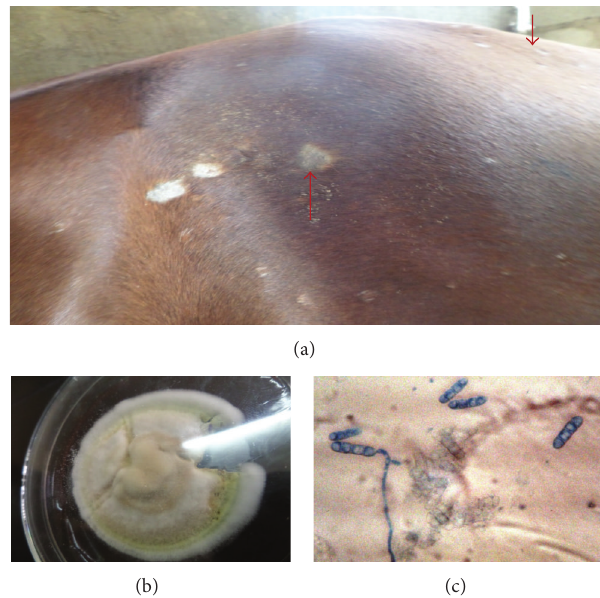
Figure 3: Generalized areas of alopecia on a horse, giving it a “moth eaten” appearance caused by T. vanbreuseghemii (a), colony of T. vanbreuseghemii (17 days) (b), microscopy of T. vanbreuseghemii (LCB × 400) showing four-celled club-shaped macroconidia, and microconidia (c).